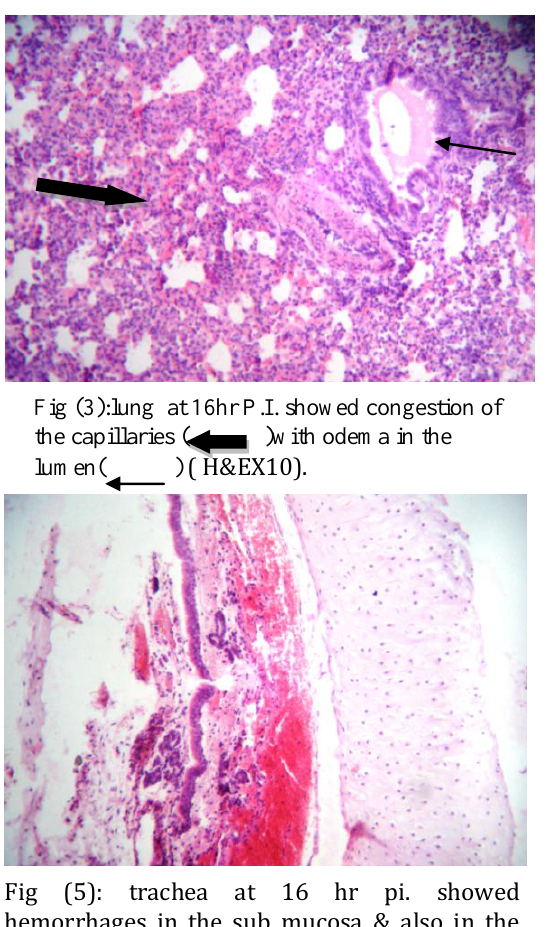
Fig (6): trachea at day 3 showed sloughing and desquamation of the epithelial lining ( ) ( H&EX10).